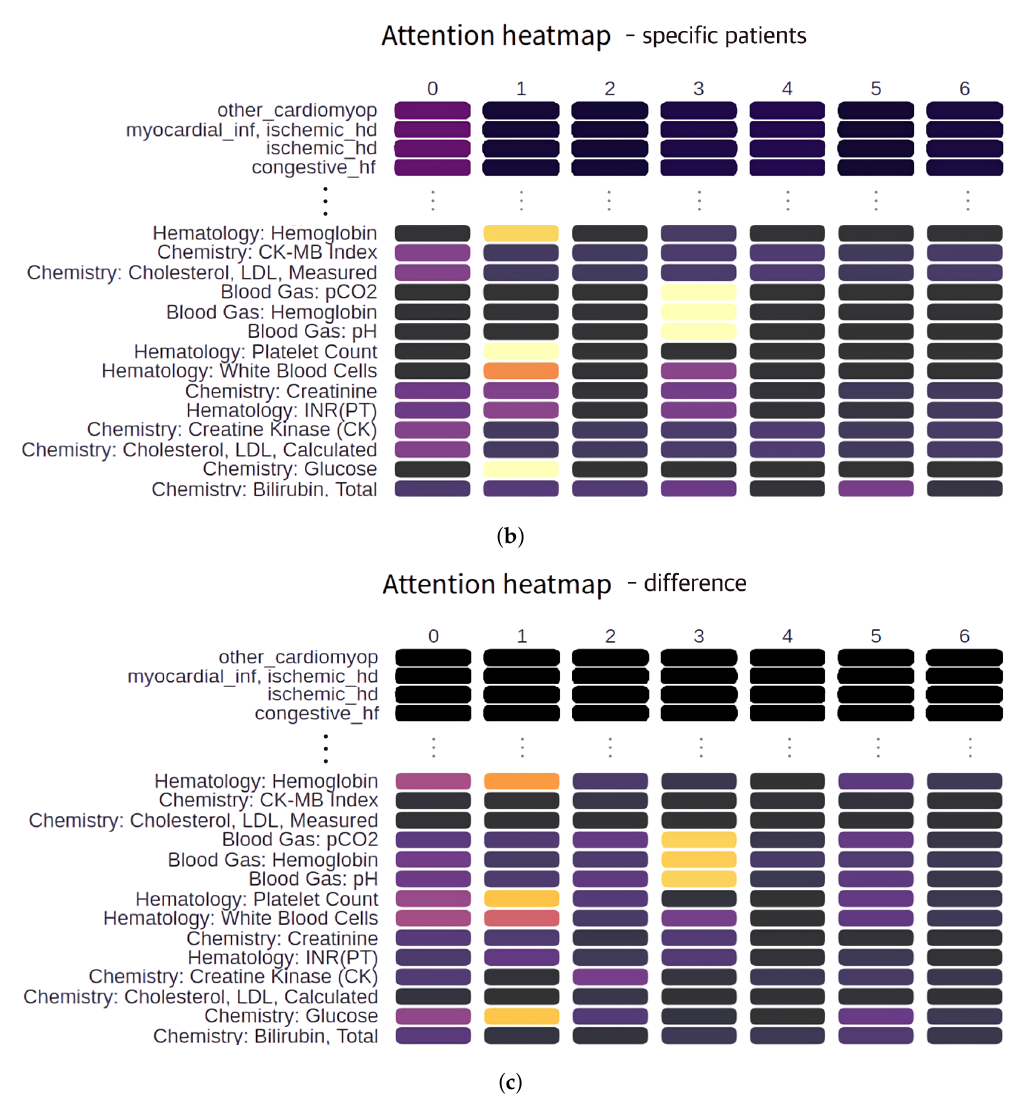
Figure 4. Attention heat maps. ( a ) Average attention for all patients in the case of cardiac surgery prediction in hospitals, ( b ) variable weights corresponding to specific patients, and ( c ) difference between the average weight for the patient group and variable weights corresponding to specific